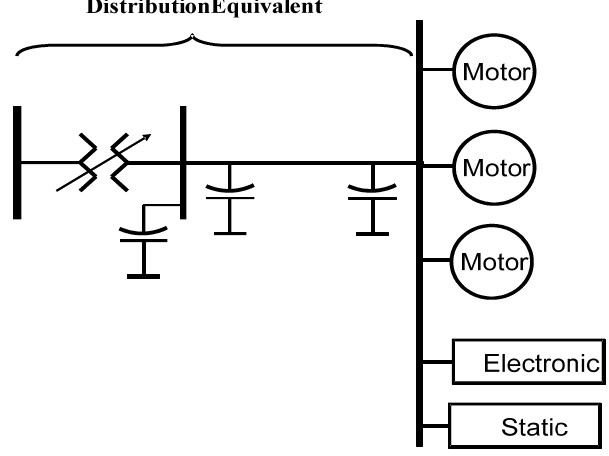
Figure 5. Western Electricity Coordinating Council (WECC) composite load model.